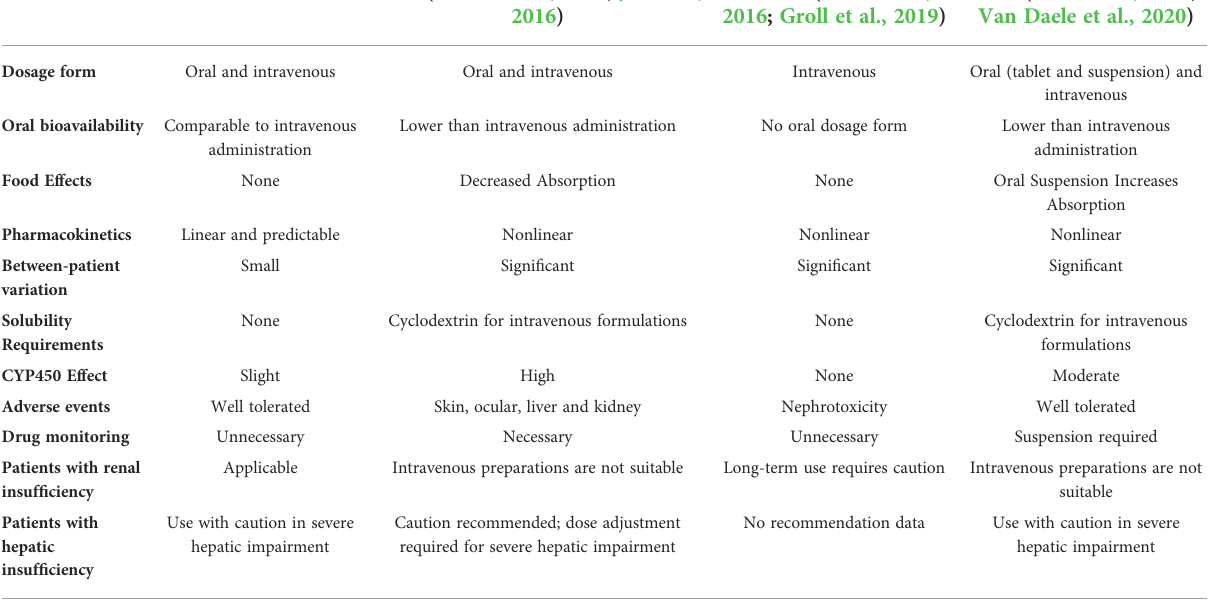
TABLE 1 Comparison of ISA with other antifungal drugs.